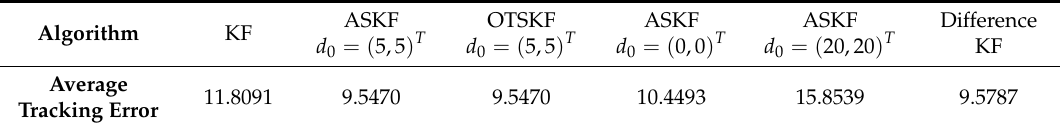
Figure 2. Comparison of the six algorithms when d k is a non-stationary time series. Table 3. The average tracking errors of the six methods.